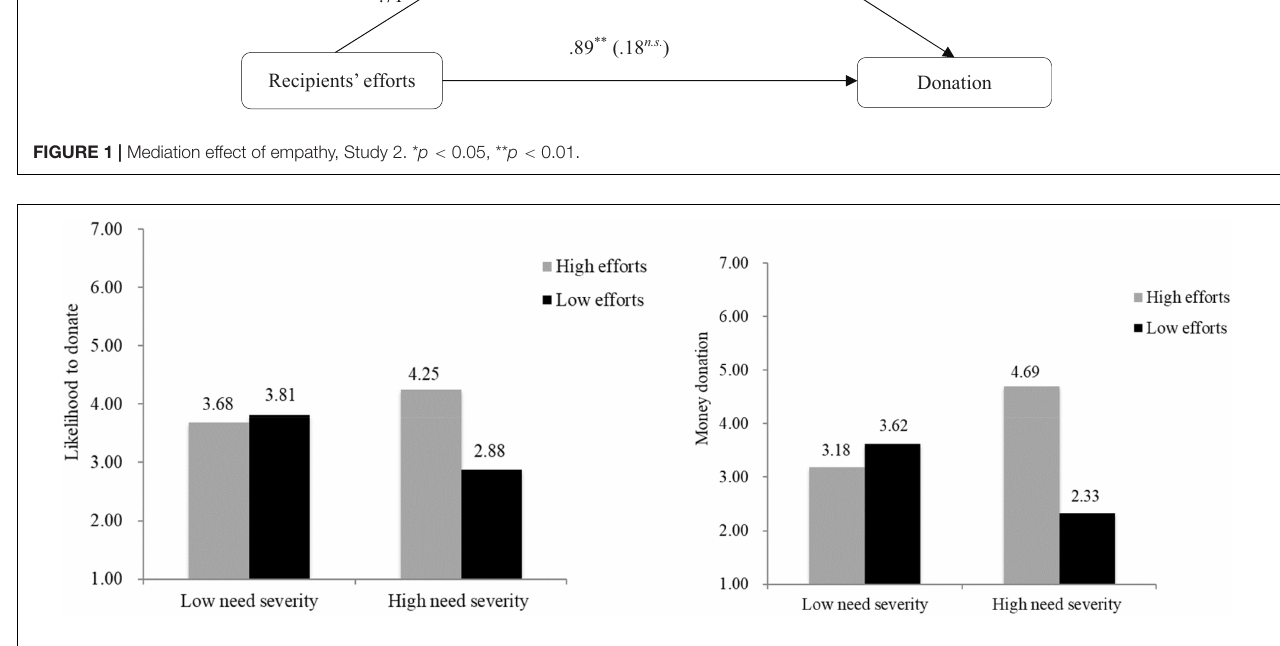
FIGURE 2 | Likelihood to donate and money donation, Study